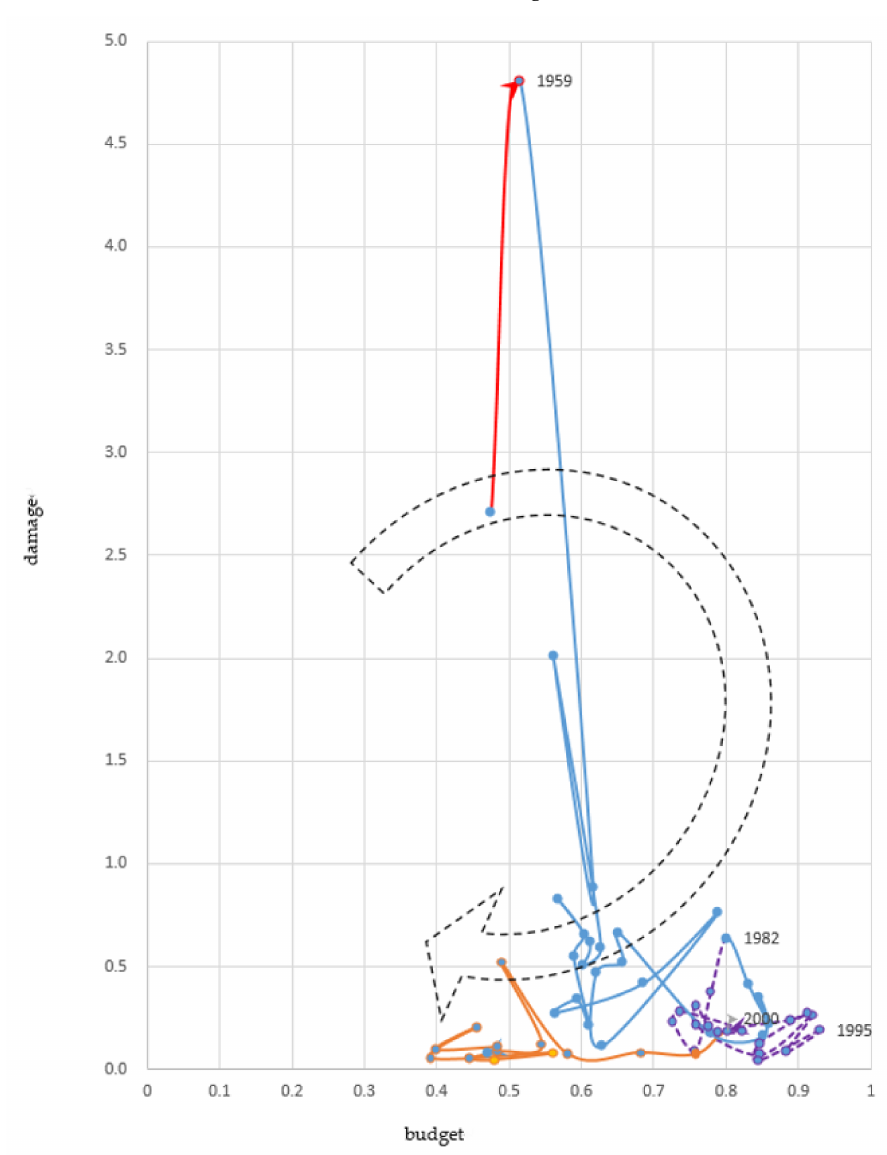
Figure 6. Fifth investment cycle 1958–2014 (Share of the National Income %). Source: Authors’ elaboration. Increasing Damage